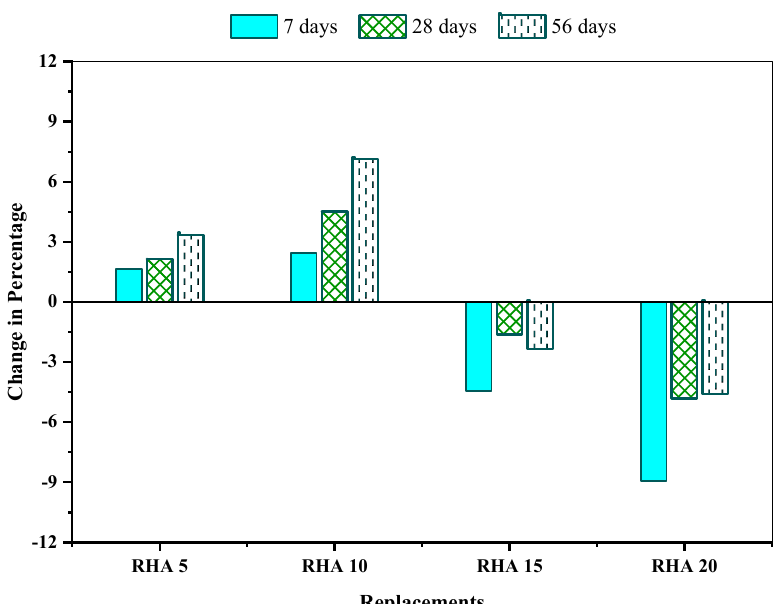
Figure 10. Splitting tensile strength change (%) of the concrete mixes in comparison with reference concrete.